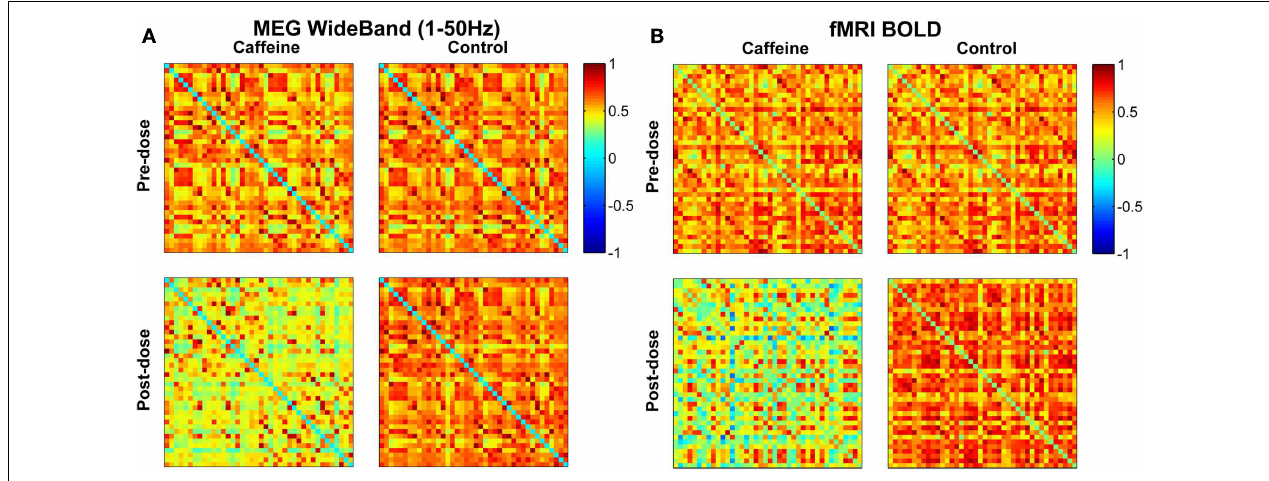
FIGURE 1 | Connectivity matrices for a representative subject in the eyes closed condition showing Pearson correlations between all pairs of ROIs for the (A) MEG wide-band (1–50Hz) data and the (B) fMRI BOLD data. Each entry corresponds to the correlation between one pair of ROIs, with the axes corresponding to the ROI indices (1–40). Both MEG and fMRI connectivity are visibly lower in the post-dose caffeine section than in the pre-dose caffeine section, while no change